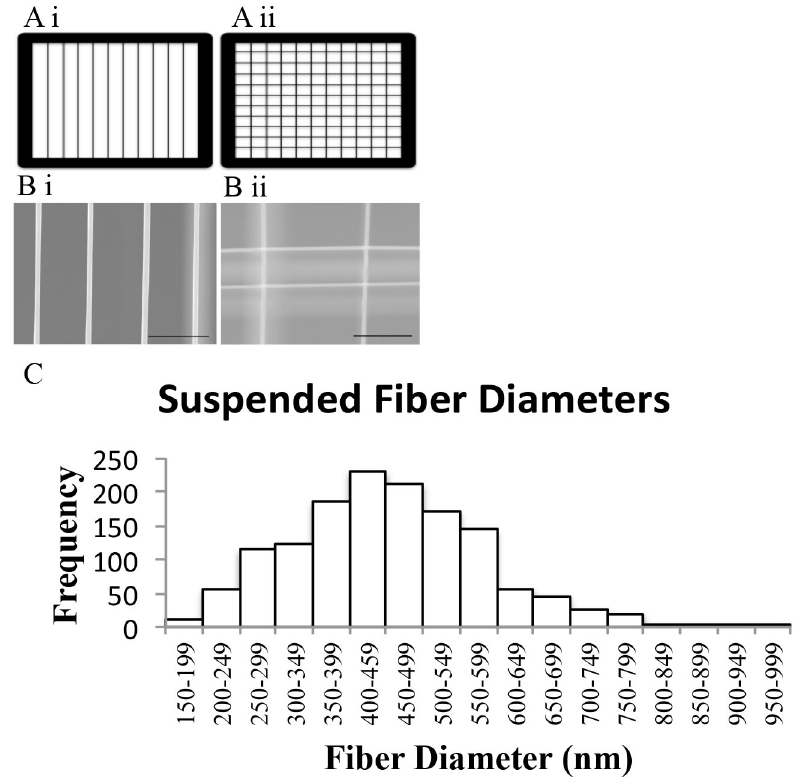
Figure 1. STEP scaffold characterization of fiber diameter. A schematic of an aligned parallel fibrous scaffold ( Ai ) and an aligned perpendicular fibrous scaffold ( Aii ); SEM images of aligned parallel fibrous scaffold ( Bi ) and aligned perpendicular fibrous scaffold ( Bii ); Scale bar 5 µ m and 3 µ m, respectively; Histogram of aligned parallel and aligned perpendicular fiber diameters, measured with ImageJ, n = 1400 ( C ).